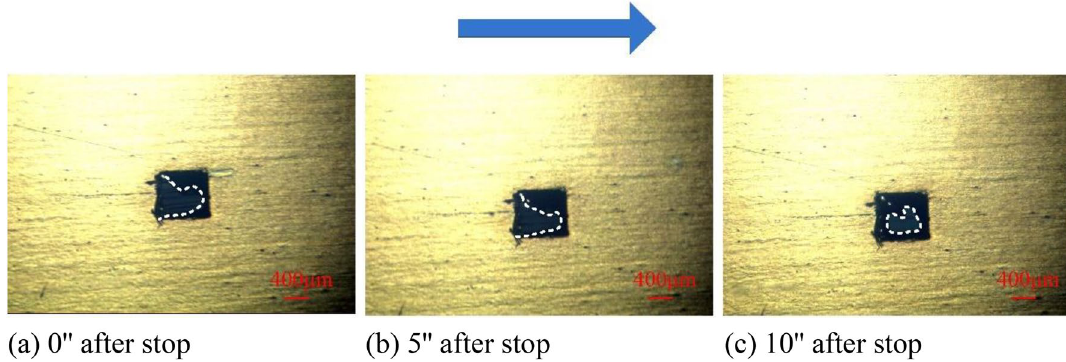
Figure 7. Cavitation bubble diagram after